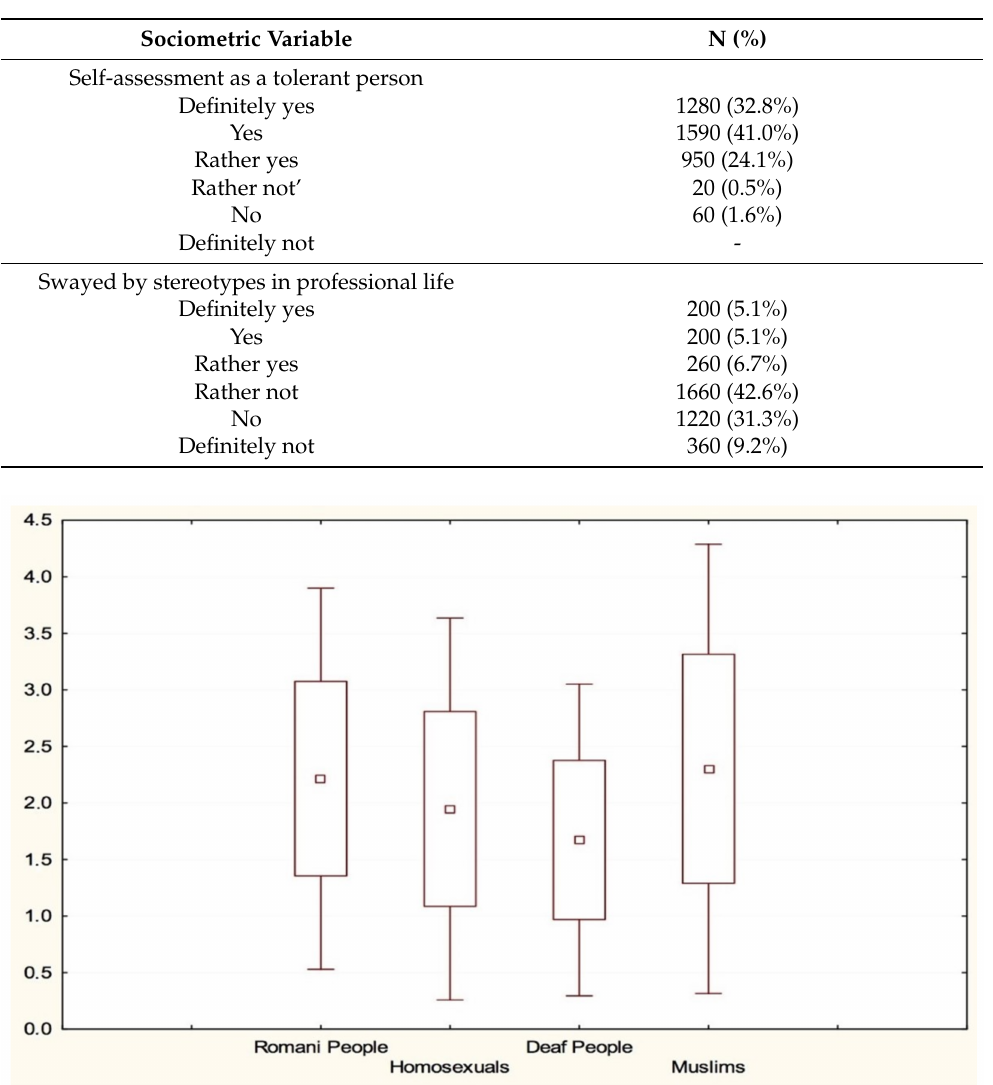
Figure 1. Mean indications of respondents towards social